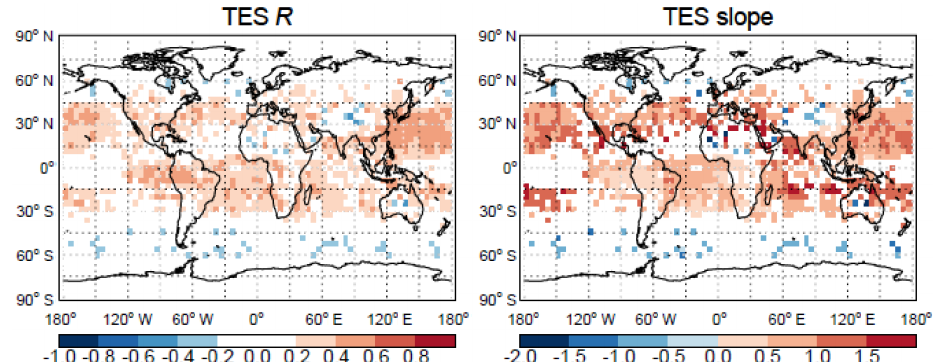
Figure 15. O 3 –CO correlation coefficients ( R ) and linear regression slopes (dO 3 / dCO) at 618hPa as determined by O 3 and CO observations from TES during July–August 2005–2009. Results are calculated in 4 ◦ × 5 ◦ grid cells. White areas denote absolute values of O 3 –CO correlation coefficients less than